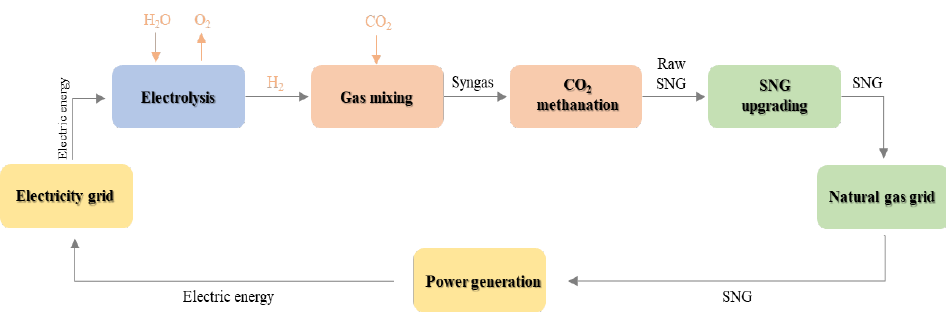
Figure 1. Schematic diagram of power to gas plant with CO 2 methanation.